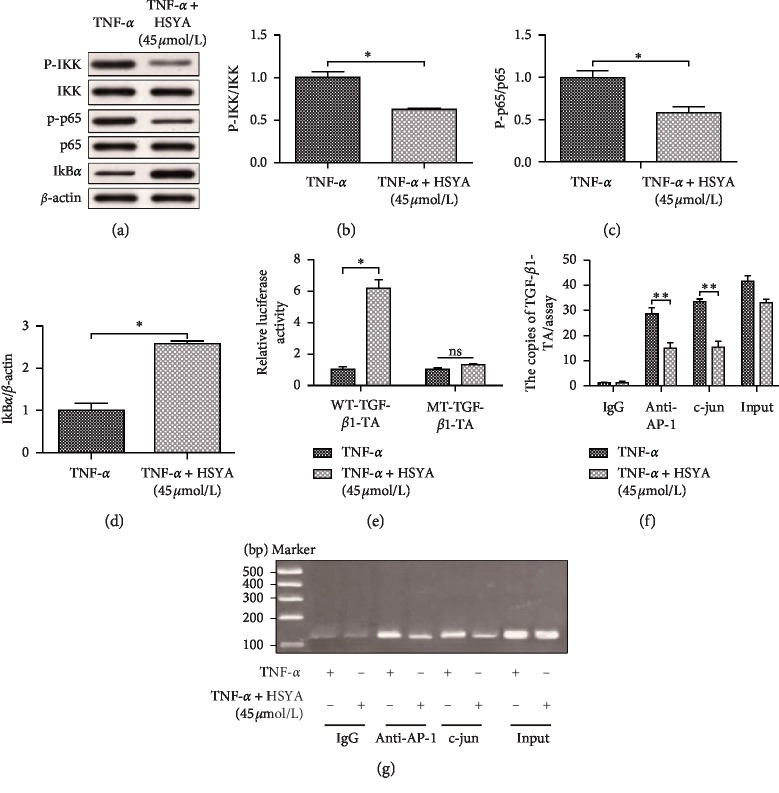
HSYA inhibits TNF-α induced proliferation and inflammatory response in MRC-5 cells via the NF-κB/AP-1 signaling pathway. (a) Western blot was used to detect the level of IKK and p65 phosphorylation and protein expression level of IκBα; (b–d) quantitative evaluation on phosphorylated levels of IKK, p65, and IκBα protein expressions; (e) luciferase reporter assay was used to detect the fluorescent activity of TGF-β1-TA. Chromatin immunoprecipitation was used to detect the binding effect of AP-1 and TGF-β1-TA using anti-AP-1 as antibody in immunoprecipitation; (f) the expression of TGF-β1-TA was detected by PCR; (g) TGF-β1-TA band was detected by agarose gel electrophoresis; HSYA, hydroxysafflor yellow A; ns, P > 0.05; ∗P < 0.05; ∗∗∗P < 0.01.